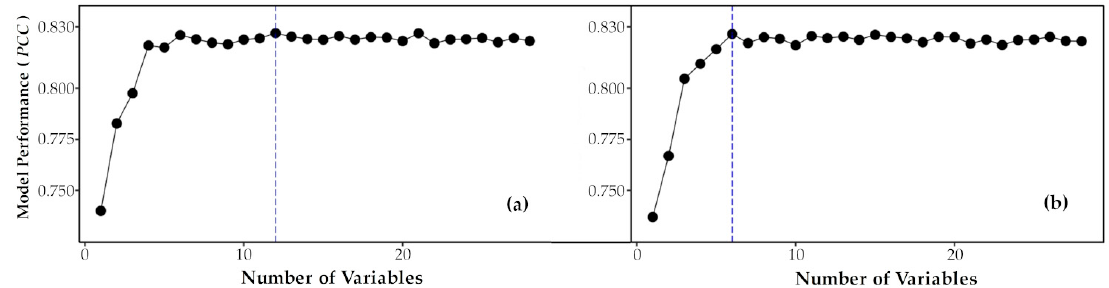
Figure 4. Pearson correlation coefficient ( PCC ) versus number of predictor variables at each step of the backward elimination procedure. The PCC values in each panel are averaged values over multiple runs; they are between the actual water prices and predicted water prices generated by reduced RFR models as variables are removed stepwise. The vertical dash lines denote the reduced models that produce the highest PCC values. Panel ( a ) refers to the procedure using node impurity based VI ranking and Panel ( b ) refers to the procedure using permutation based VI ranking.